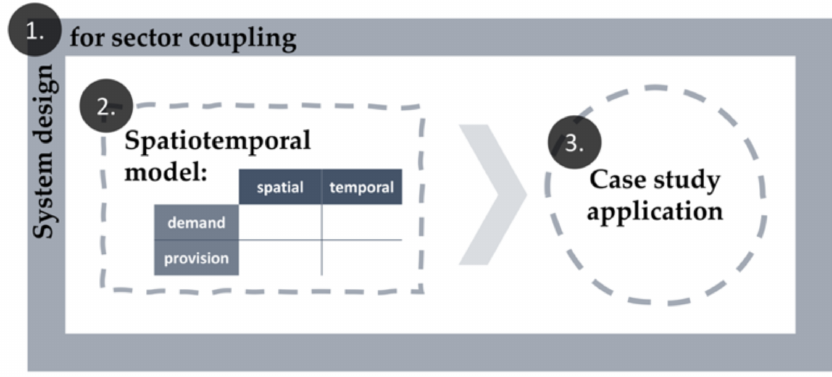
Figure 1. Visualisation of the methodological